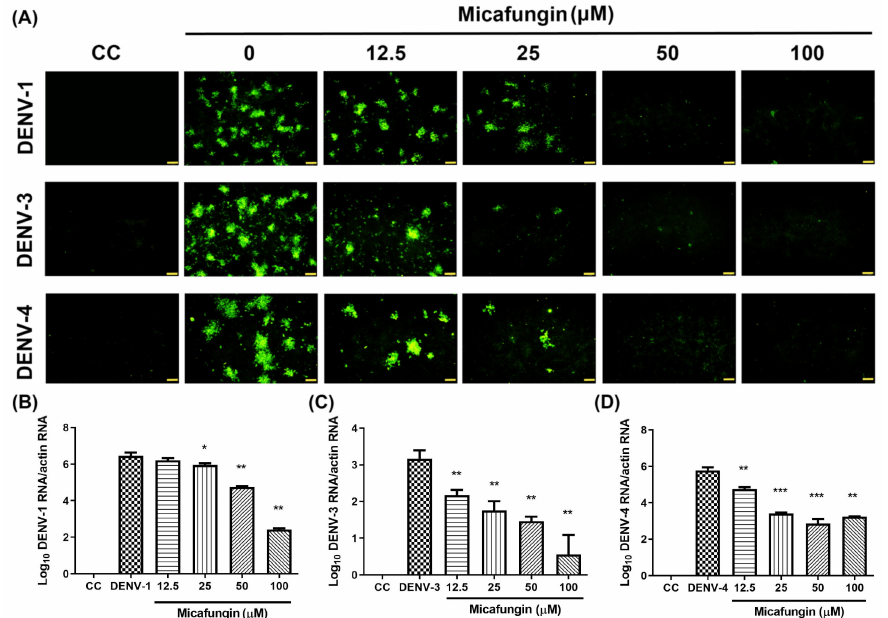
Figure 6. Antiviral effects of micafungin against other serotypes of DENV: ( A ) IFA results obtained under DENV-1, DENV-3, and DENV-4 infection. RNA levels of ( B ) DENV-1, ( C ) DENV-3, and ( D ) DENV-4, as determined using RT-qPCR assay. All data were obtained from at least three independent experiments, where significance was indicated as follows: * p < 0.05; ** p < 0.01; *** p < 0.001. Scale bar: 100 µ